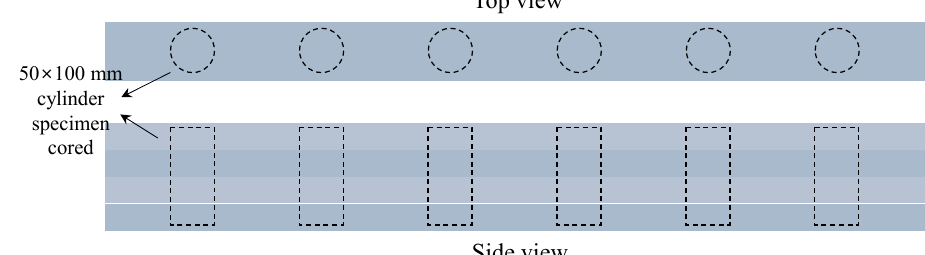
Figure 11. Relationship between spindle shaft rotation speed and printing mass per min.